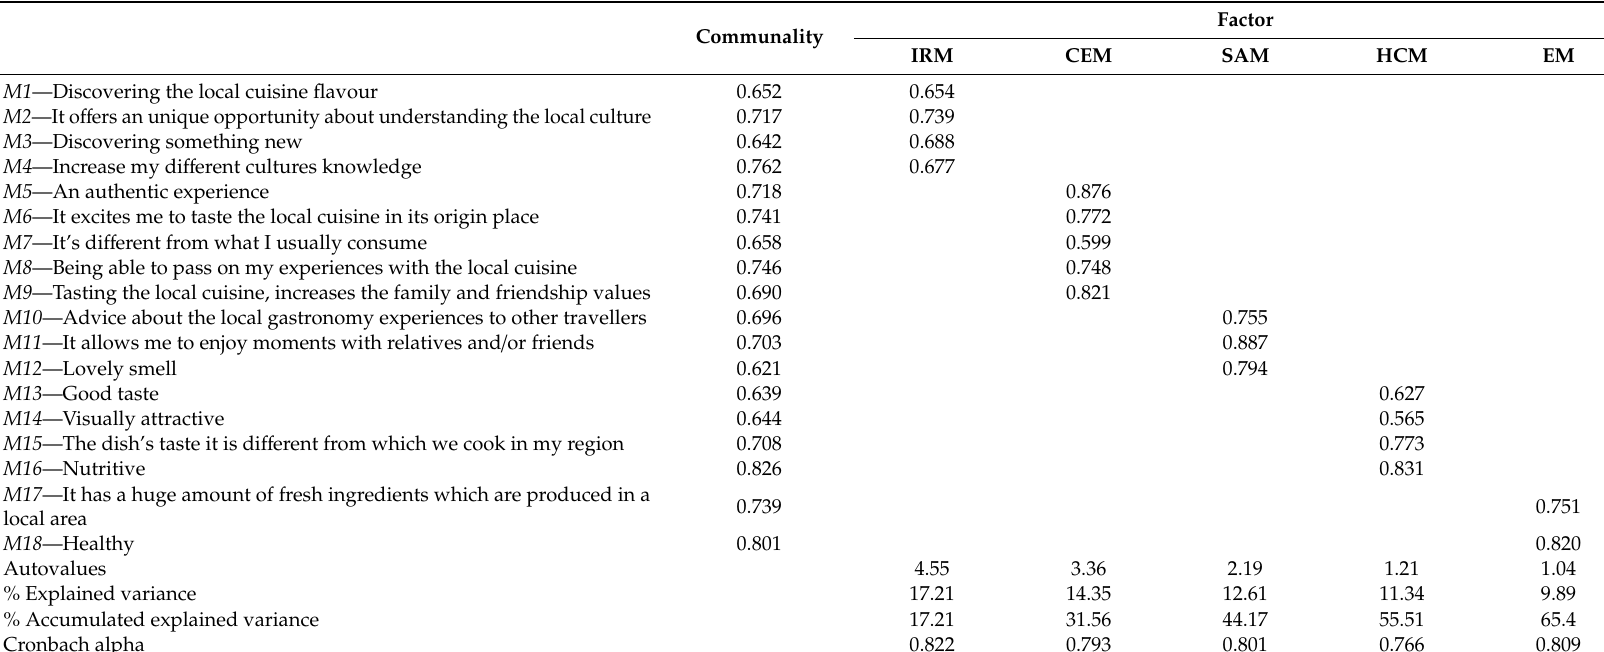
Table 2. Exploratory factor